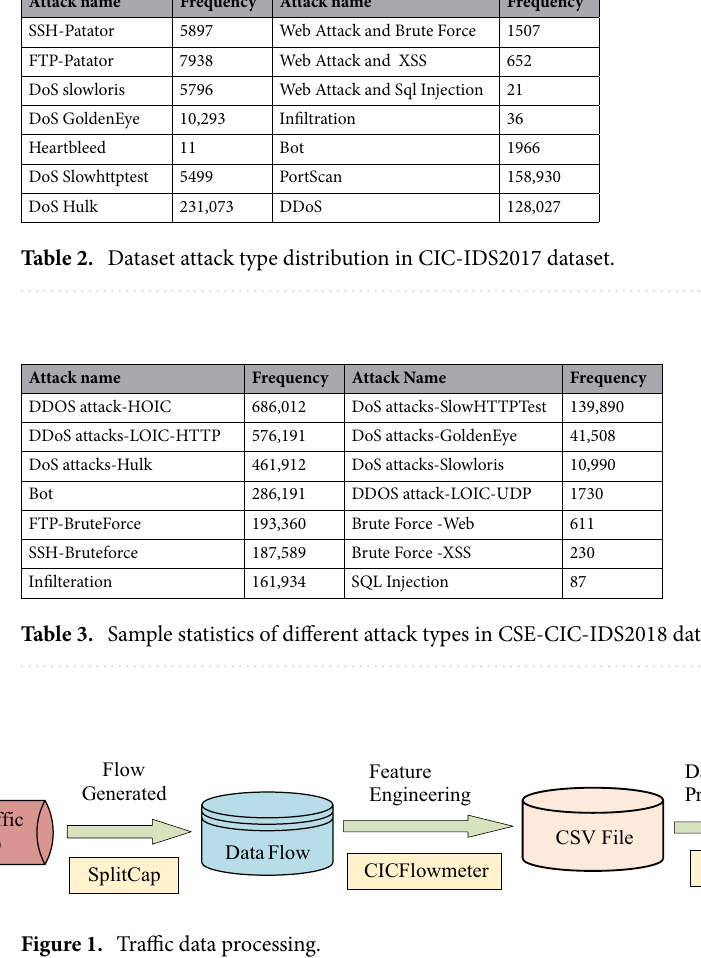
Figure 1. Traffic data